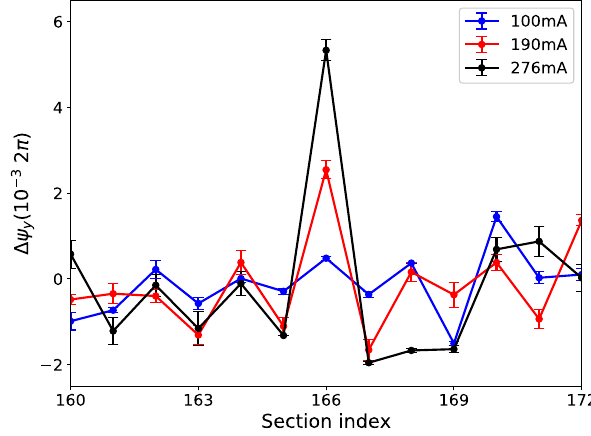
FIG. 10. Variation of the vertical phase advance as a function of beam current around the location of a 7 m long damping wiggler (section 166), which has a flat chamber.